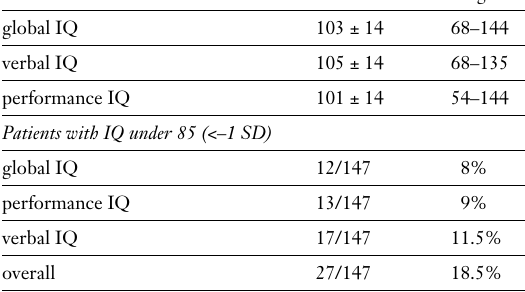
Global intellectual achievement (n = 147 patients